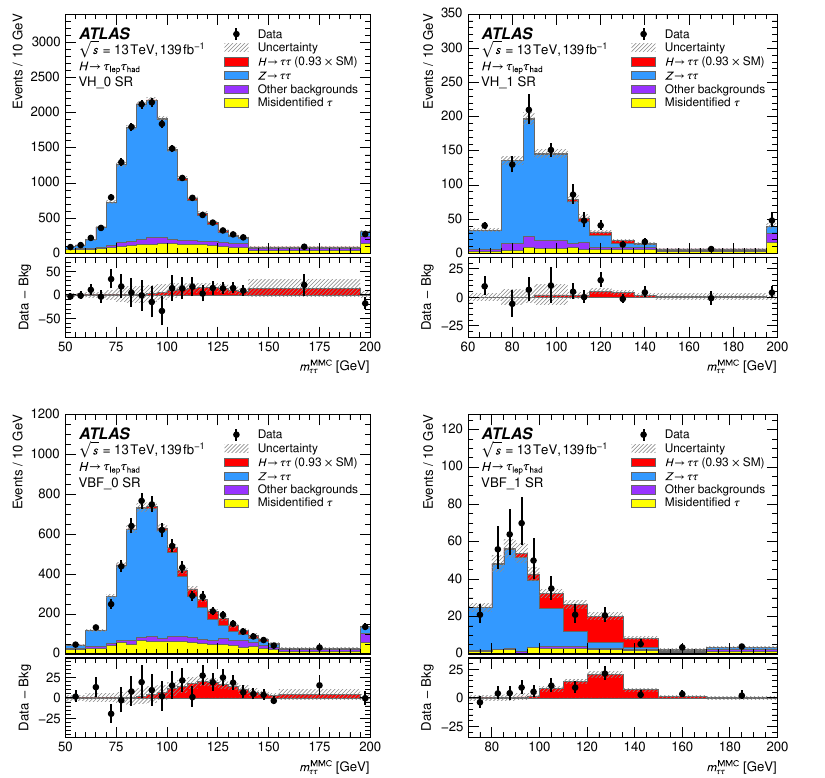
Figure 17. Distribution of the reconstructed ττ invariant mass ( m MMC ) for all events in the ττ V(had)H and VBF categories of the τ τ channel. The bottom panel shows the differences lep had between the numbers of observed data events and expected background events (black points). The observed Higgs boson signal, corresponding to ( σ × B ) / ( σ × B ) = 0 . 93 , is shown with a filled red SM histogram. Entries with values above the x -axis range are shown in the last bin of each distributions. The dashed band indicates the total uncertainty on the total predicted yields. The prediction for each sample is determined from the likelihood fit performed to measure the pp → H → ττ